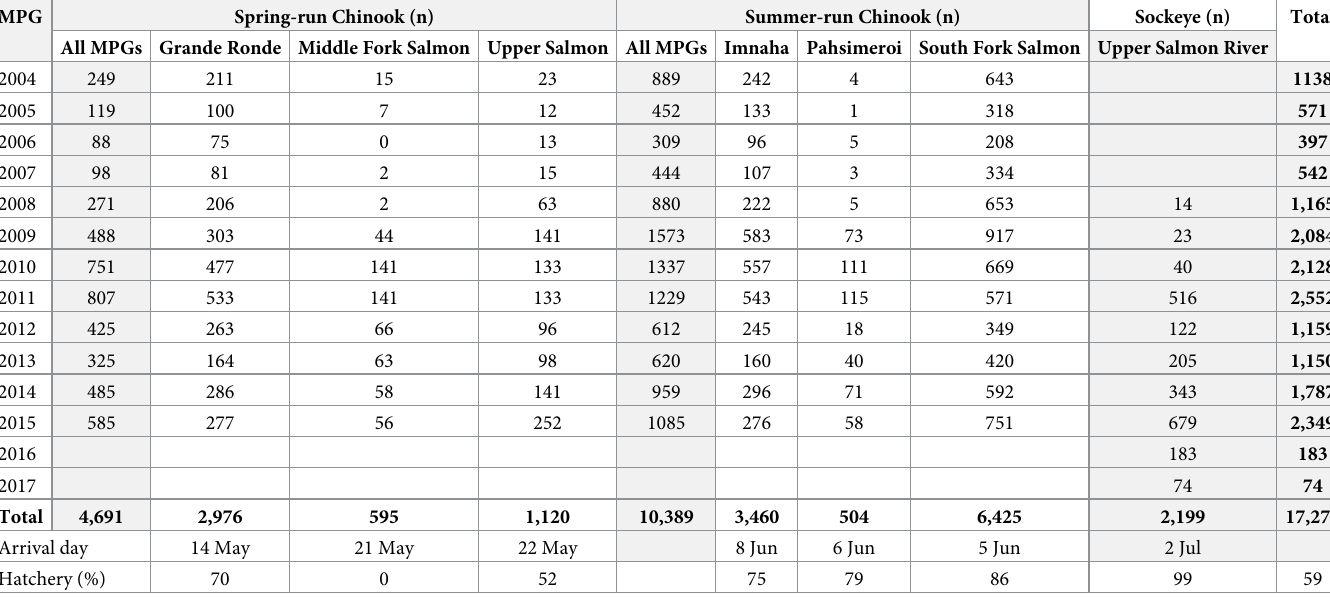
Table 1. Characteristics of the observation